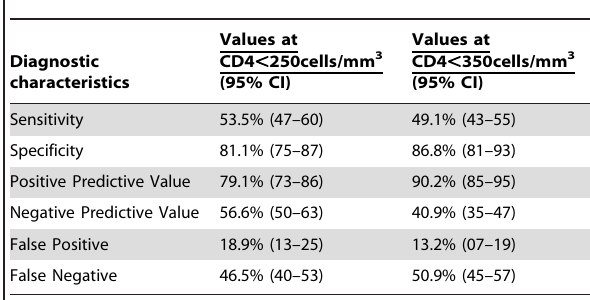
Table 2. Diagnostic characteristics of the WHO HIV/AIDS clinical staging guidelines at the CD4 cell count of less than 250 cells/mm 3 and 350 cells/mm 3 among 395 participants in JCRC Mengo, Kakira and Kasana health centres,